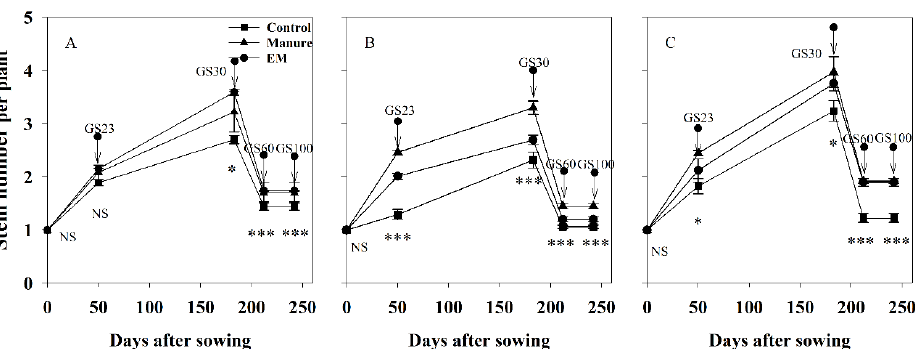
Figure 3. The dynamic of stem number of individual plant across three years. A, B and C means 2015, 2016, and 2017, respectively. Vertical bars represent ± S.E. of the mean. GS23, GS30, GS60, GS100 before the winter, start of stem elongation, beginning of anthesis, and physiological maturity stages, respectively. NS, not significant; * Significant at p < 0.05; *** Significant at p < 0.001.